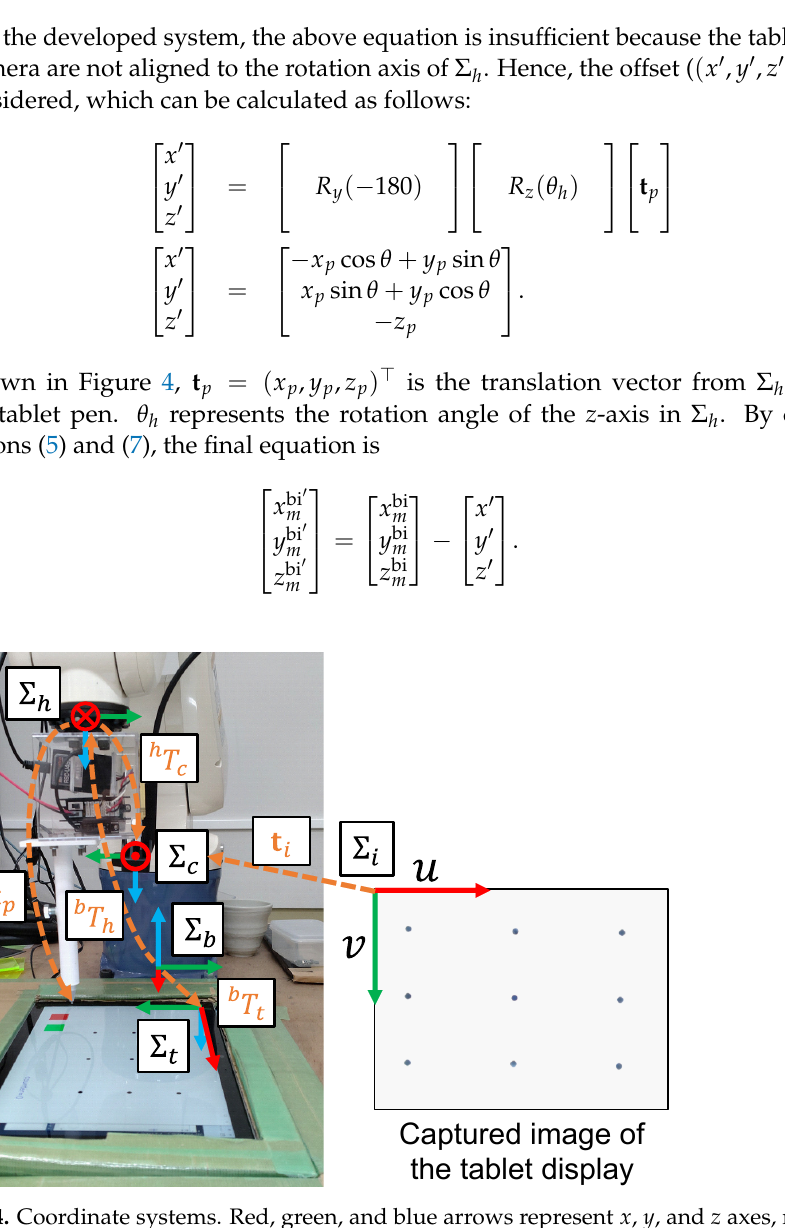
Figure 4. Coordinate systems. Red, green, and blue arrows represent x , y , and z axes, respectively. DENSO VP-6242 robot [20] is